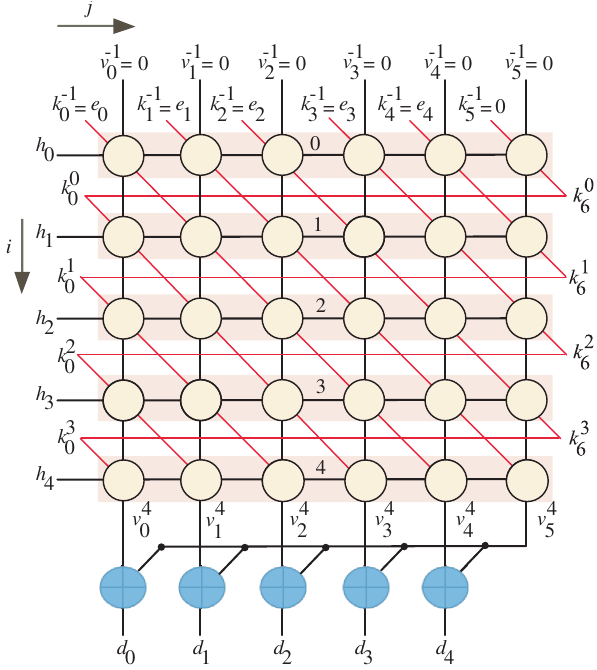
Figure 2. Scheduling time for n =